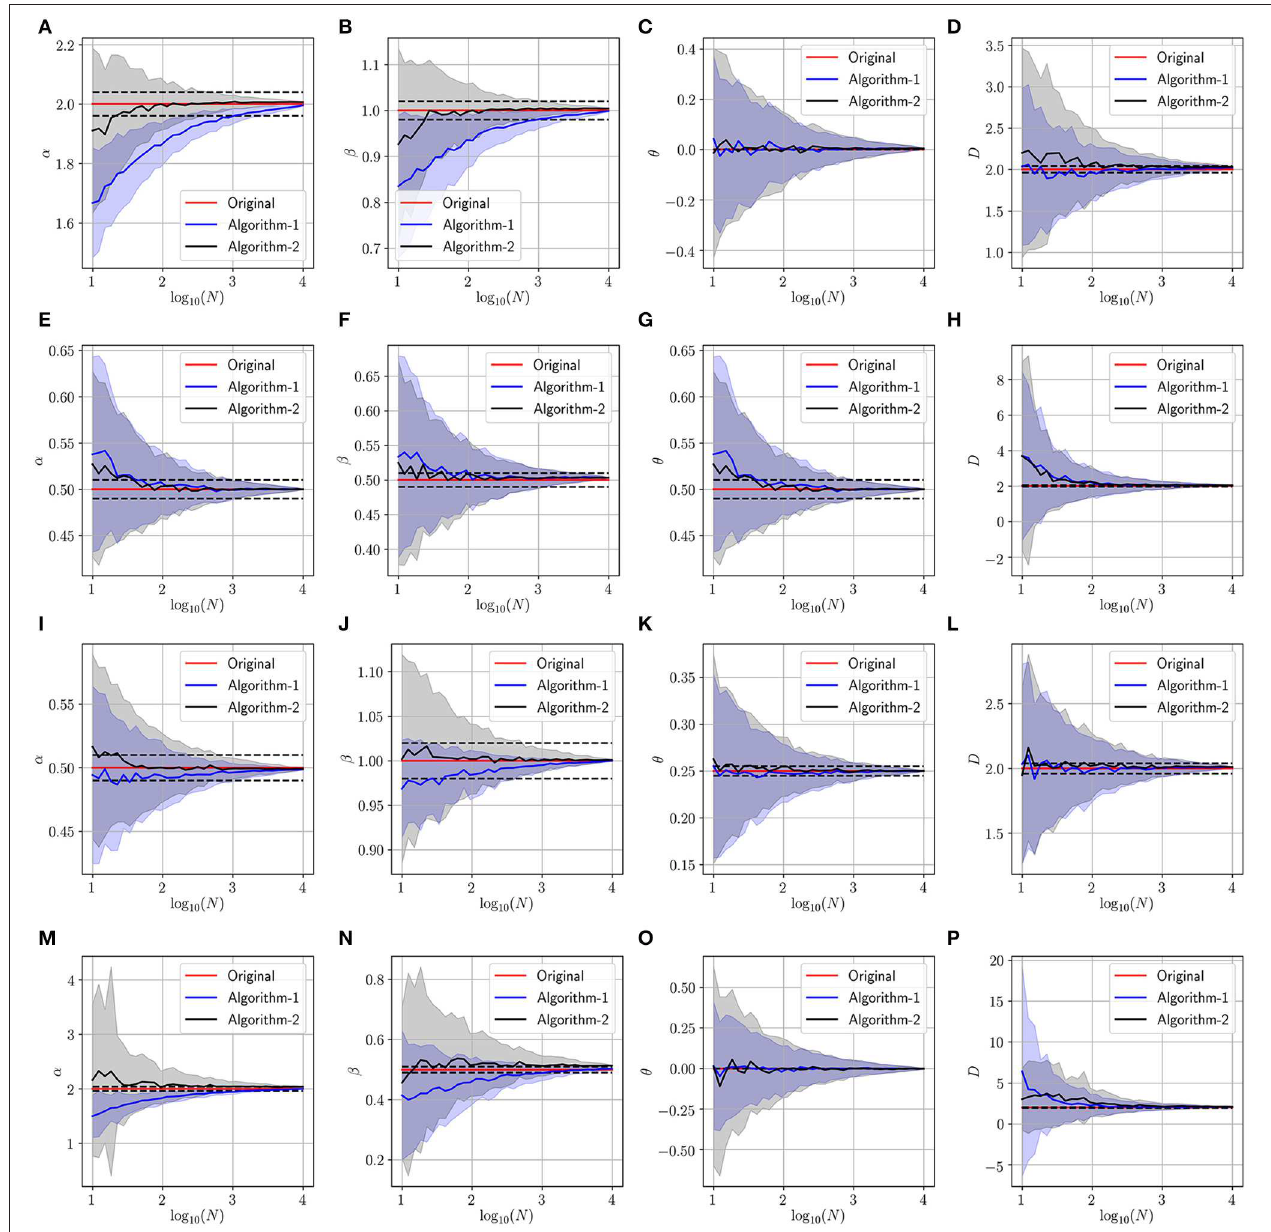
FIGURE 4 | Determining the parameters of the space-time fractional diffusion via the two proposed algorithms while varying the number of trajectories and the generalized diffusion coefficient D 2. The dotted line indicate 2 % error tube around the original parameter value in the red: (A–D) Normal diffusion equation = ( α 2, β 1, θ 0), (E–H) Neutral diffusion equation ( α 0.5, β 0.5, θ 0.5), (I–L) Space fractional diffusion equation ( α = = = = = = fractional diffusion equation ( α 2, β 0.5, θ 0). = = =